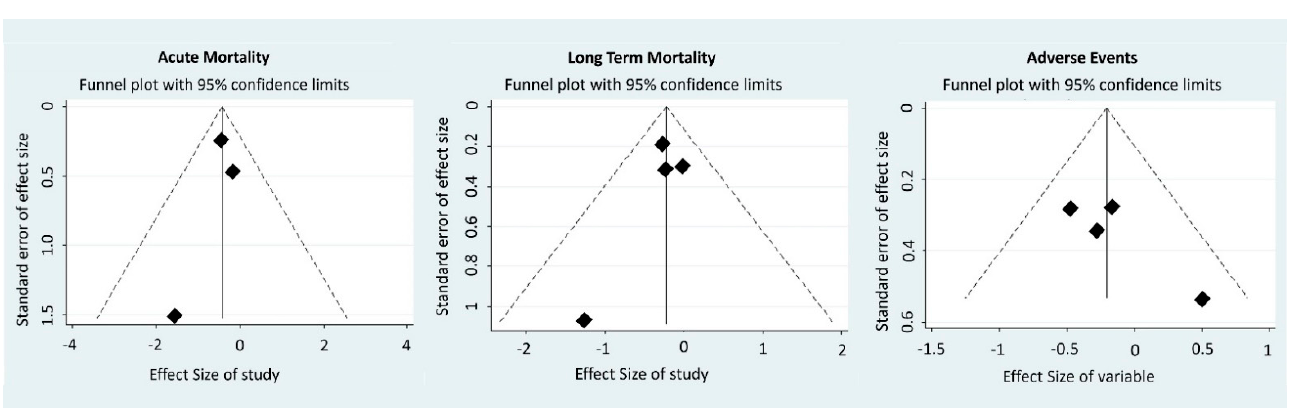
Figure A1. Funnel Plots.